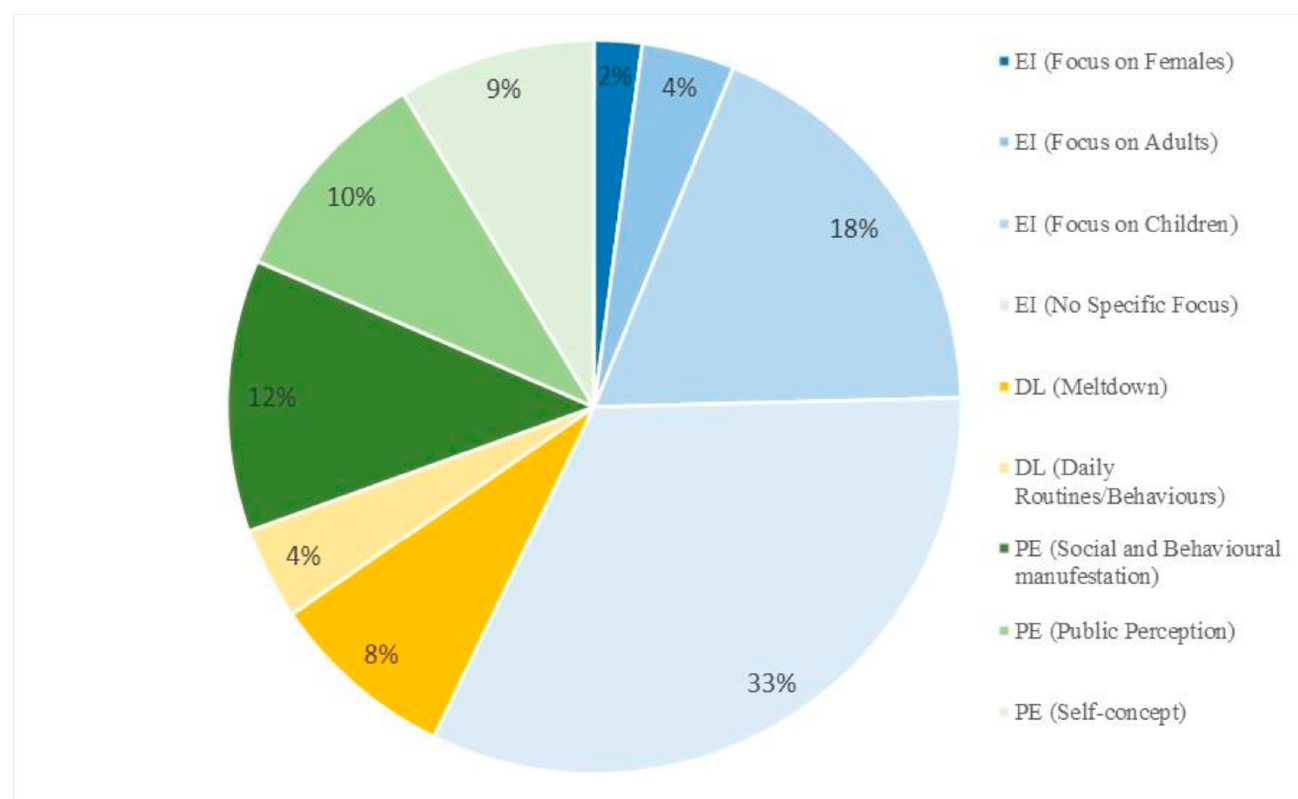
Figure 1. Major themes and subthemes presented in the ASD-related videos. N = 50. EI represents the theme “providing educational Information”. PE represents the theme “personal experience”. DL represents the theme “daily life videos”. In brackets are the subthemes for each.